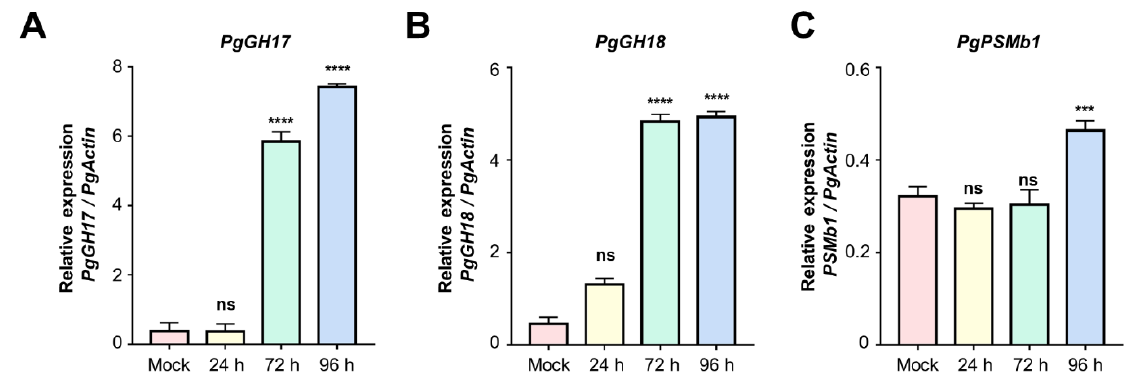
Figure 4. Bar charts showing the mRNA expression levels of PgGH17, 18 , and PgPSMb1 genes in mock, 24 h, 72 h, and 96 h salt-stress-treated ginseng leaves, as measured by qRT-PCR analysis. The data are represented by the means of at least three replicates, and significant differences are indicated between the mock and salt-treated samples. (ns indicates no significance, *** indicates significance of p < 0.001, **** indicates significance of p < 0.0001).